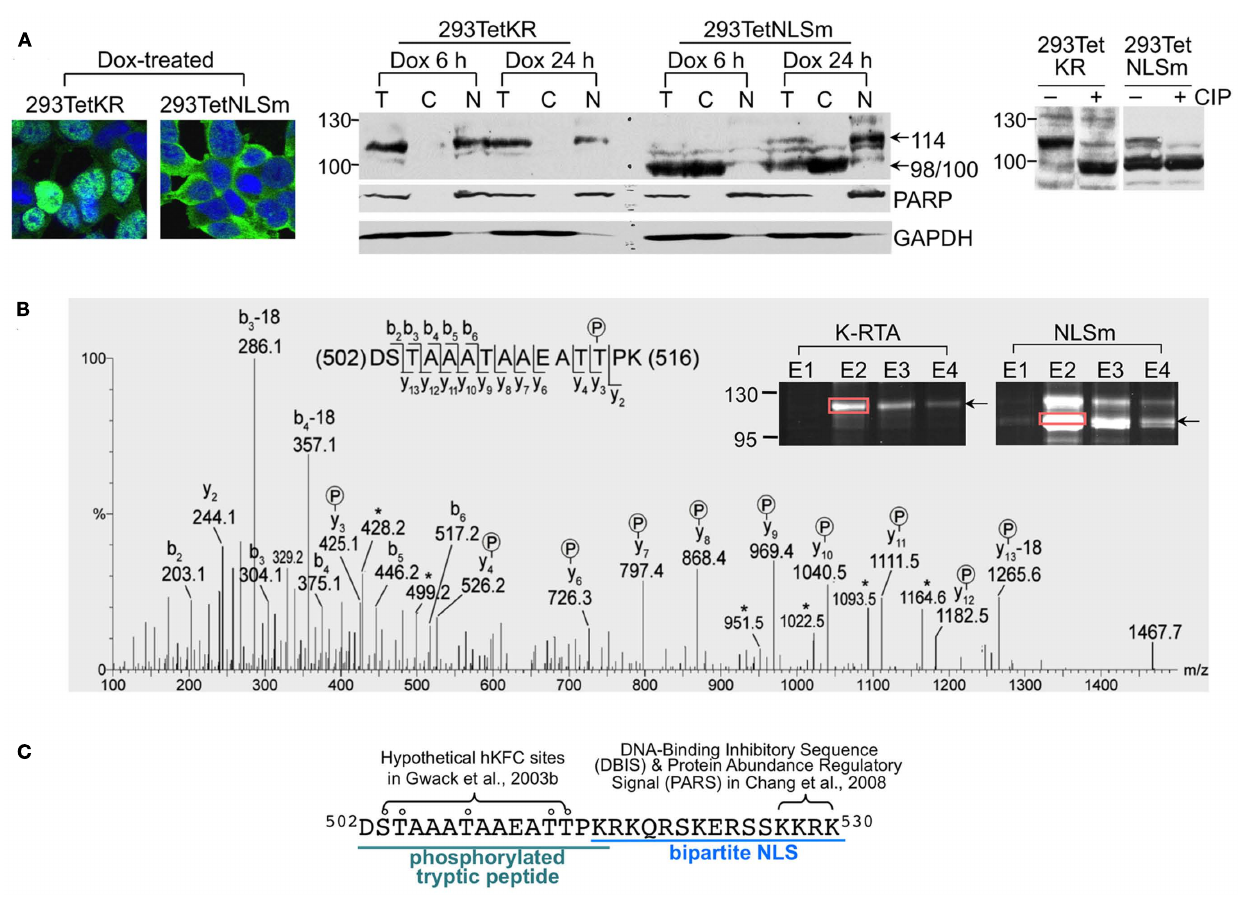
FIGURE 2 |Thr-513 andThr-514 of K-RTA is the primary in vivo phosphorylation motif identified by mass spectrometry. (A) (Left) distinct subcellular localization of K-RTA and NLSm was revealed in doxycycline (Dox, 50ng/ml)-treated 293TetKR and 293TetNLSm cells by an immunofluorescence assay using M2 FLAG antibody. (Middle) subcellular fractionation of protein lysates prepared from 6 to 24h Dox-treated 293TetKR and 293TetNLSm cells.T, total lysate; N, nuclear fraction; C, cytosolic fraction. PARP and GAPDH served as the nuclear and cytosolic indicators, respectively. (Right) protein lysate of the 293TetKR and 293TetNLSm was preincubated with ( + ) or without ( − ) calf intestinal alkaline phosphatase (CIP) at 37˚C for